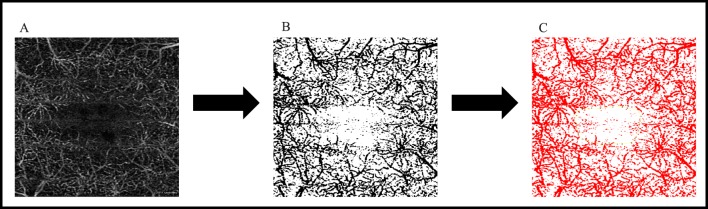
Illustrates the steps by which the algorithm calculates TVA and FAZ area in the SCP and DCP. (A) Shows the DCP of a patient, which is then binarized using Otsu global thresholding to generate (B). All black pixels are quantified and marked in red to calculate the TVA, as shown in (C). The FAZ is manually delineated on (C) to generate the FAZ area.